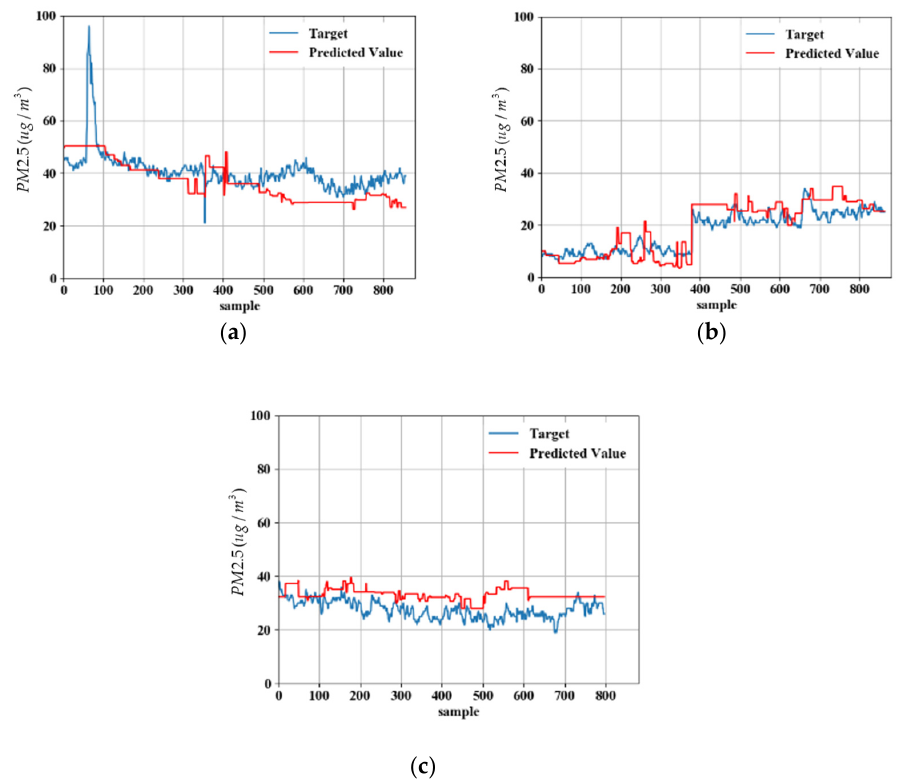
Figure 18. Prediction results of the decision tree model: model prediction results for ( a ) 15 February, ( b ) 28 February, and ( c ) 1 March 2019.